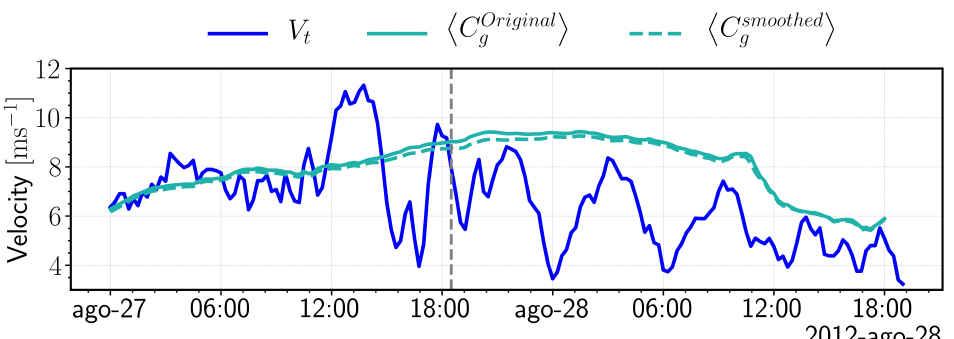
(cid:10) (cid:11) C g ) using